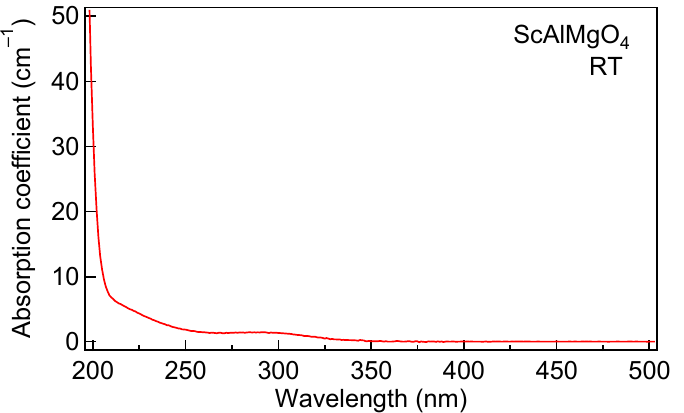
Figure 9. Room-temperature absorption coefficient profile of the SCAM crystal calculated from the transmission spectra.